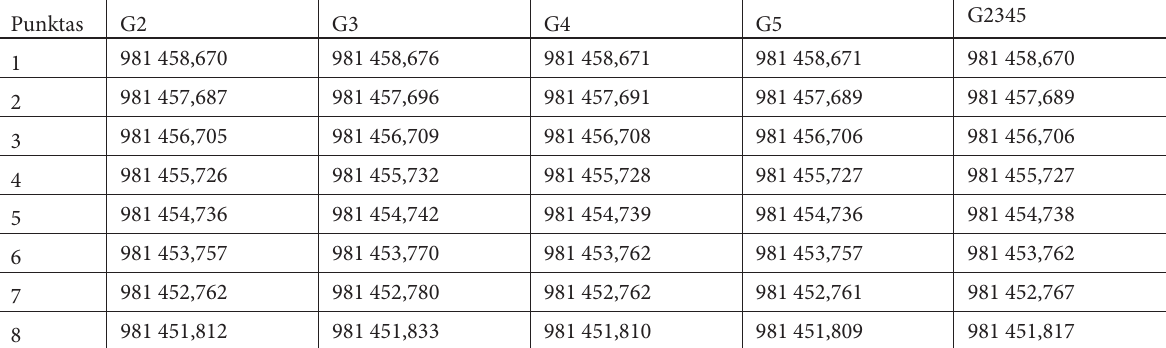
Table 2. The gravity acceleration mgal